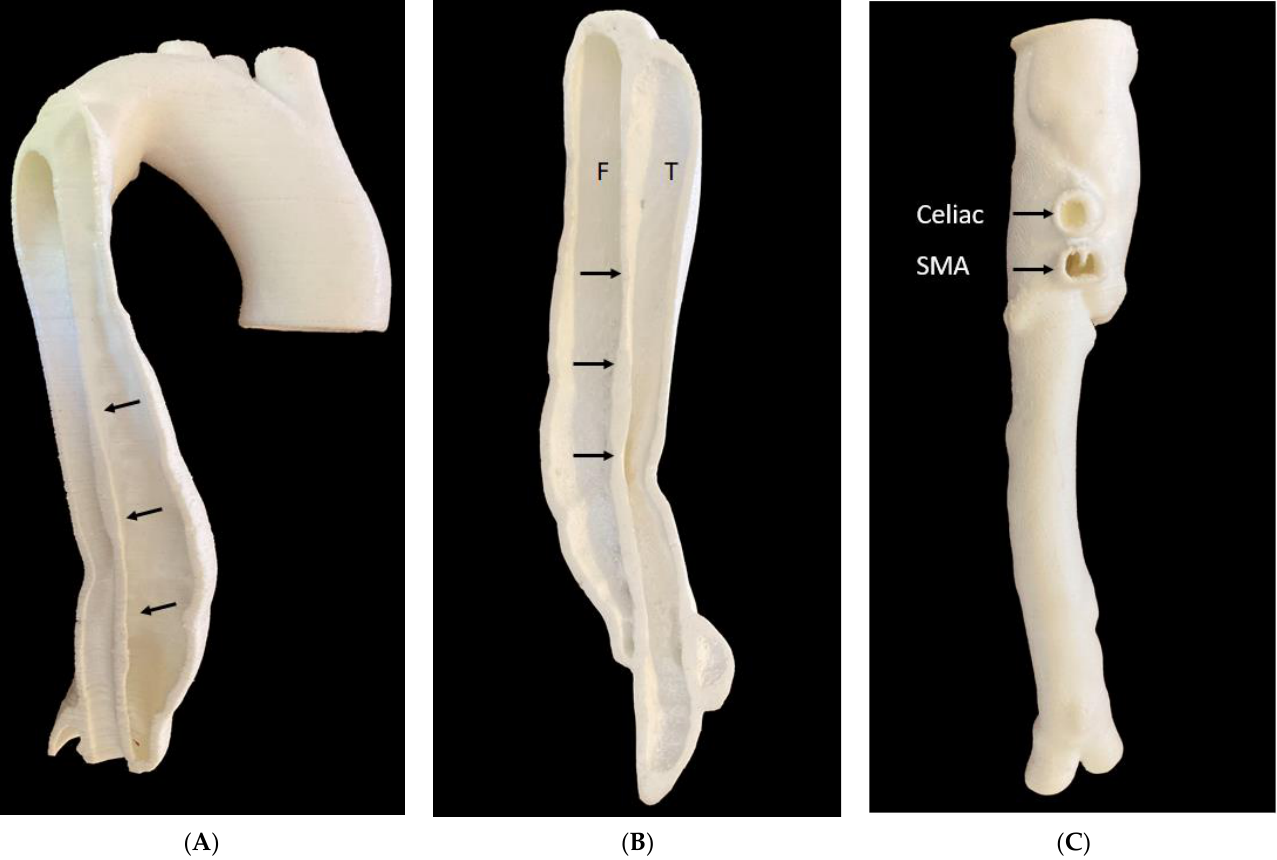
Figure 13. 3D-printed type B aortic dissection model with use of thermoplastic polyurethane material. ( A ): Internal view of the main part of the 3D model with aortic lumen separated into true and false lumen by an intimal flap (arrows). ( B ): The other piece of the 3D model with a demonstration of true and false lumens. Arrows refer to the intimal flap. ( C ): Lower part of the 3D model with abdominal aorta and main branches (celiac and SMA) and common iliac arteries. F — false lumen, T — true lumen, SMA — superior mesenteric artery.